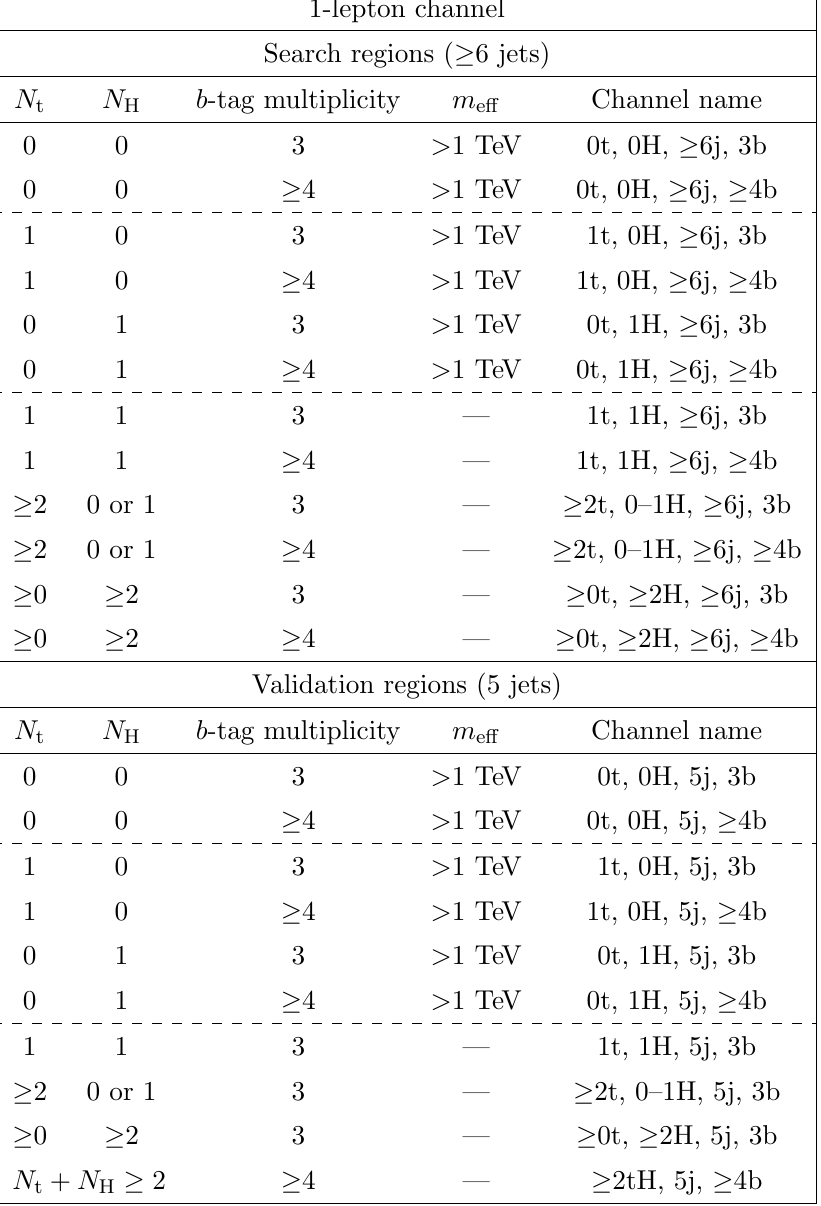
Table 2. De(cid:12)nition of the search and validation regions (see text for details) in the 1-lepton